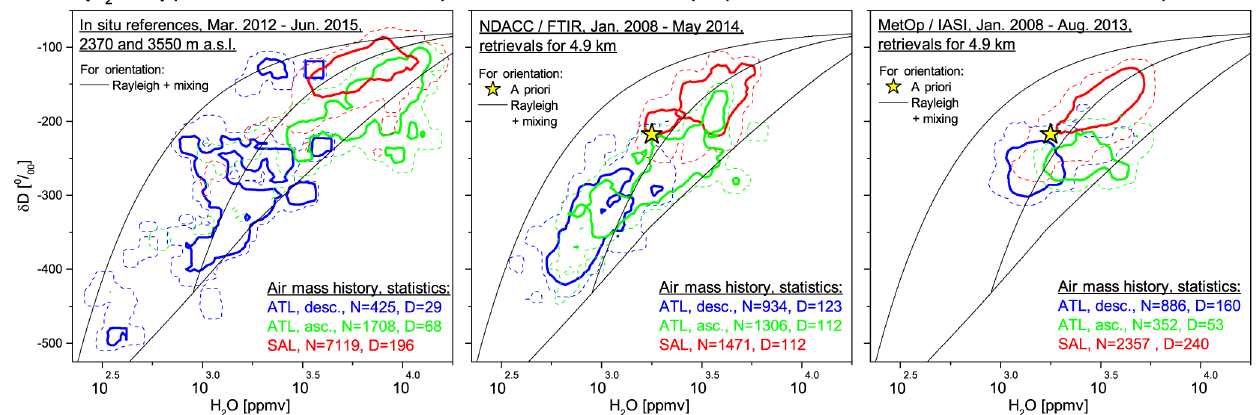
Figure 5. Free tropospheric {H 2 O, δ D} pair distributions as obtained by different measurement techniques in the surroundings of Tenerife (for orientation see also map as shown in Fig. C1). The contour lines indicate areas with the highest densities of the {H 2 O, δ D} pairs: red denotes air masses that are clearly affected by dry convection over the African continent; blue and green denote Atlantic air masses with different pathways (see Table 3). The thin dashed and thick solid lines mark the areas that include 95% and 66% of all data, respectively. Left: two Picarro in situ instruments (L2120-i) measuring during nighttime at 2390 and 3550ma.s.l. (Izaña Observatory and Teide). Middle: ground-based NDACC/FTIR located at Izaña. Right: space-based MetOp/IASI-A and MetOp/IASI-B observing in a 2 ◦ × 2 ◦ area south of the island. In addition, the panels show three simulated curves (thin black lines): a Rayleigh curve for initialization with T = 25 ◦ C, RH = 80% and δ D = − 80‰ and two mixing curves (first line for mixing between H 2 O [ 1 ] = 25000ppmv; δ D [ 1 ] = − 80‰ and H 2 O [ 2 ] = 900ppmv; δ D [ 2 ] = − 430‰ and second line for mixing between H 2 O [ 1 ] = 25000ppmv; δ D [ 1 ] = − 80‰ and H 2 O [ 2 ] = 200ppmv; δ D [ 2 ] = − 610‰). The yellow star marks the a priori value used for the remote sensing retrievals at